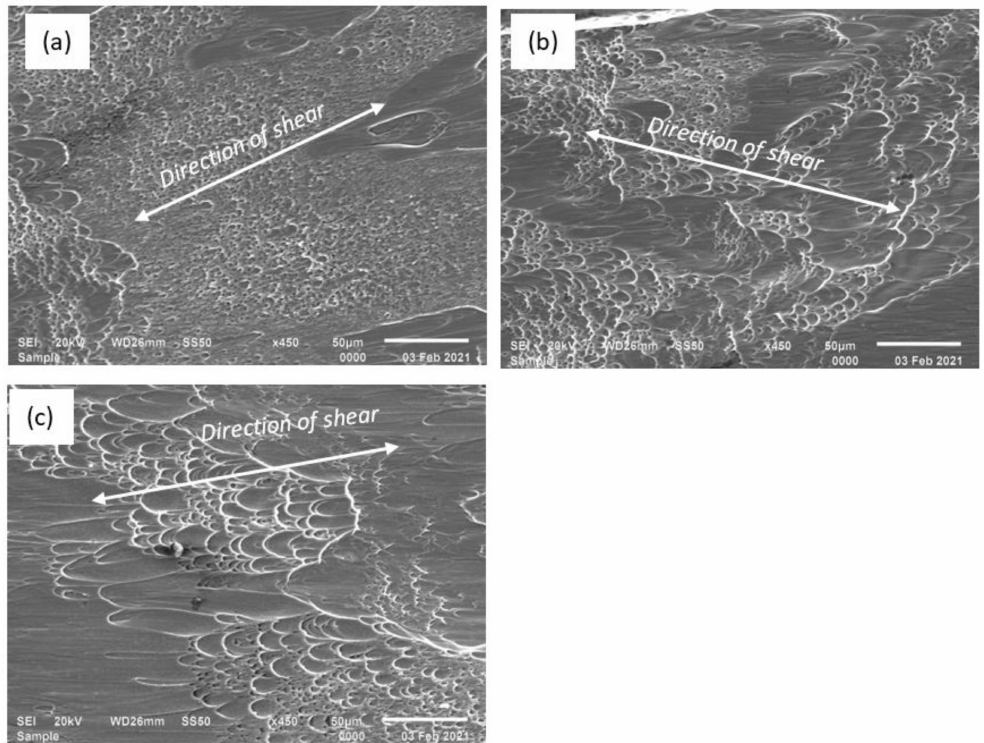
Figure 20. Typical characteristic features on the fracture surfaces of samples C at temperatures of ( a ) 25 ◦ C, ( b ) 200 ◦ C, and ( c ) 500 ◦ C at a magnification of X450.